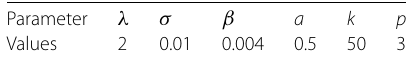
Parameter λ σ β a k p